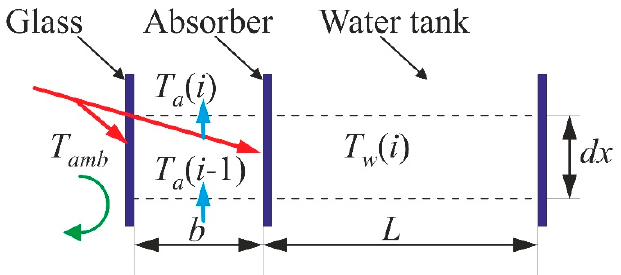
Figure 3. Computational scheme of the problem .